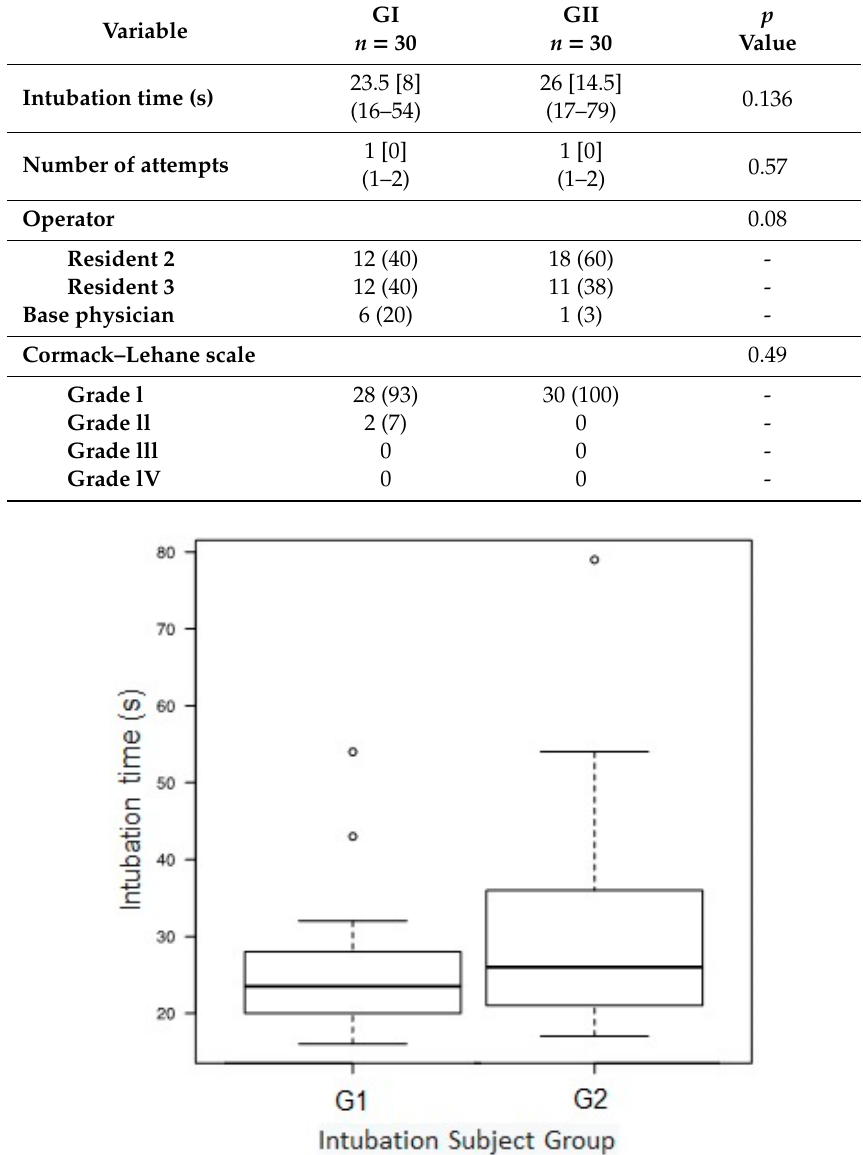
Table 3. Performance comparison of intubation with a VLG Hybrid 1.0 (GI) and with a VDL C-Mac (GII).